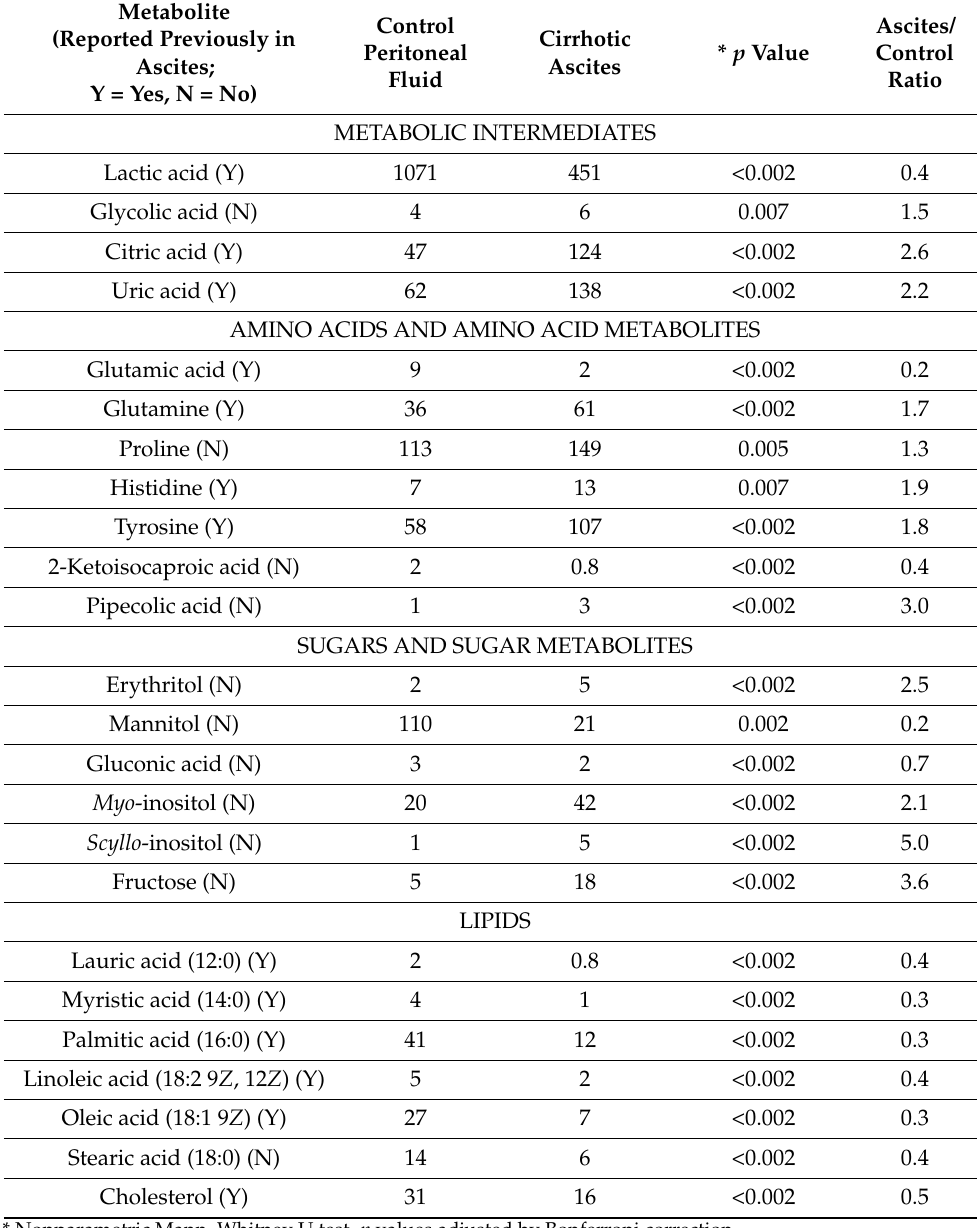
Table 1. Metabolites showing a difference in relative concentration between ascitic fluid from cirrhotic patients and peritoneal fluid from postoperative surgical